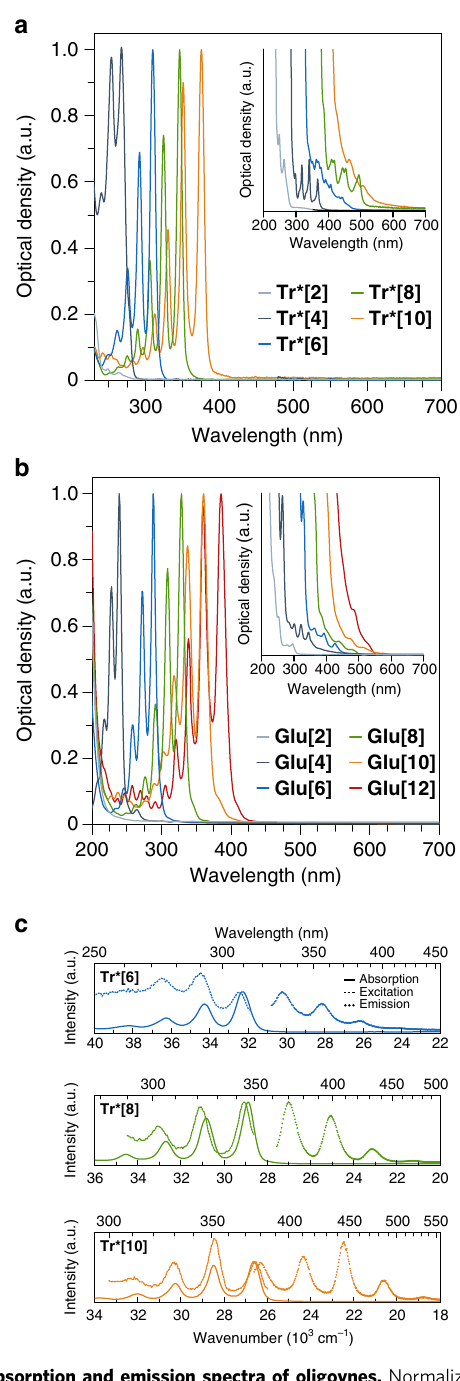
Fig. 2 Absorption and emission spectra of oligoynes. Normalized absorption spectra of a the Tr*[ n ] and b the Glu[ n ] series recorded in hexane and acetonitrile, respectively. The insets show the additional bands with weak intensity at wavelengths higher than the longest wavelength absorption maximum ( λ main ). c Steady-state absorption (solid line), emission (em., dotted line), and excitation (exc., dashed line) spectra in hexane of Tr*[6] (em. λ exc = 290 nm; exc. λ = 355 nm), Tr*[8] (em. λ exc = 320 nm; exc. λ = 400 nm), and Tr*[10] (em. λ exc = 330 nm; exc. λ = 446 nm). Source data are provided as a Source Data fi